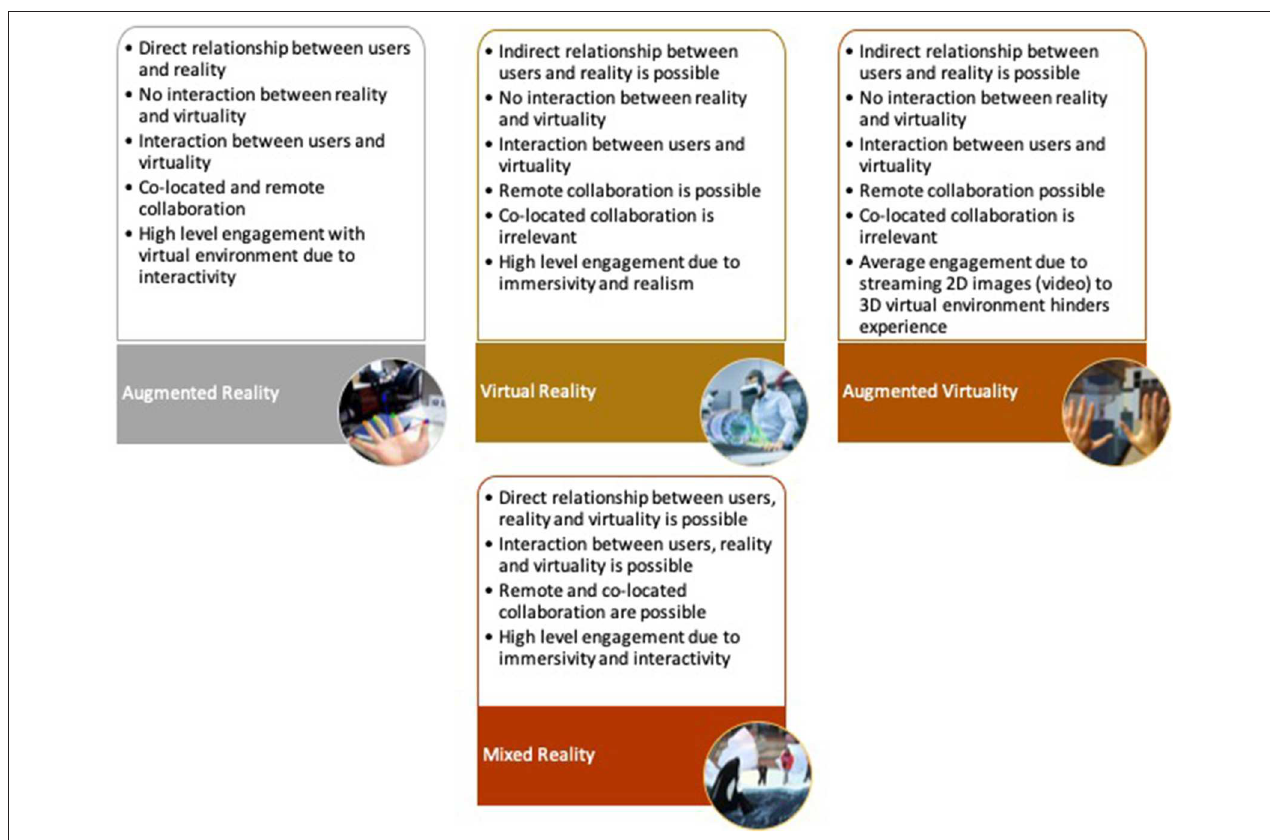
FIGURE 2 | Identified capabilities of immersive reality technologies based on a comparison of their features against the three criteria (relationship, collaboration, and engagement). This figure is a summary of Table 3